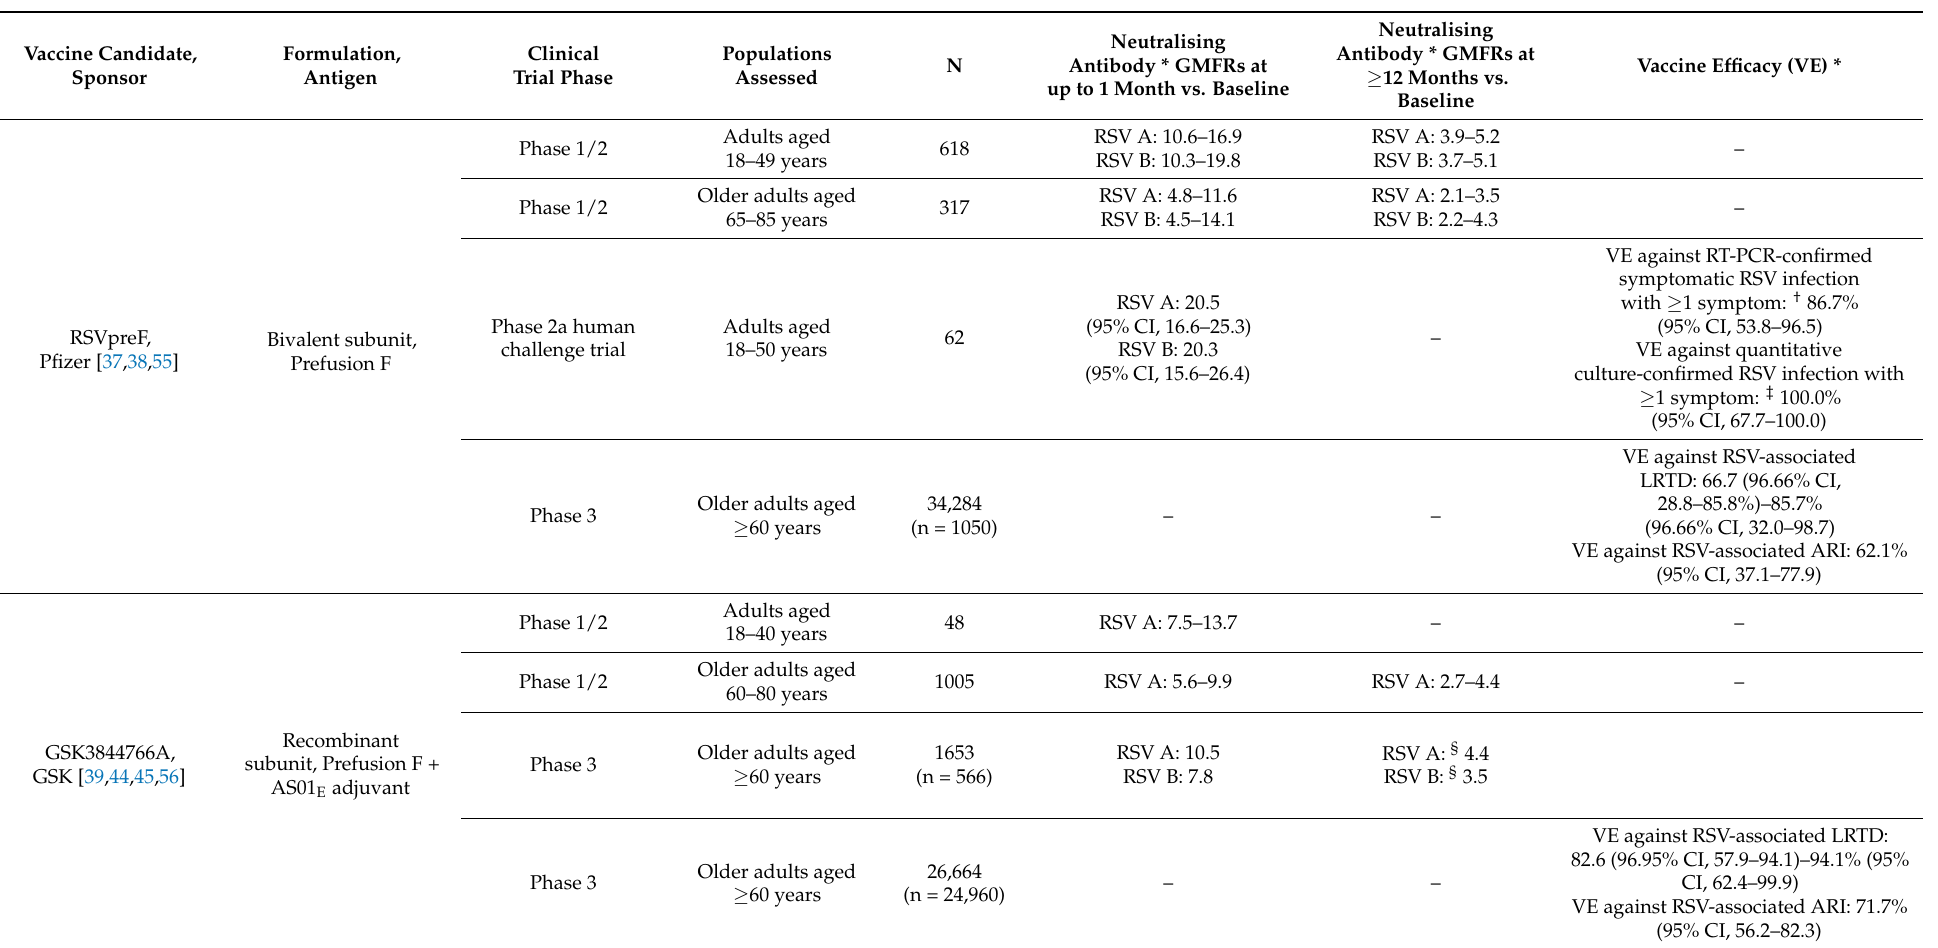
Table 1. Neutralising antibody responses to current Phase 3 RSV vaccine candidates in healthy and older adults in clinical